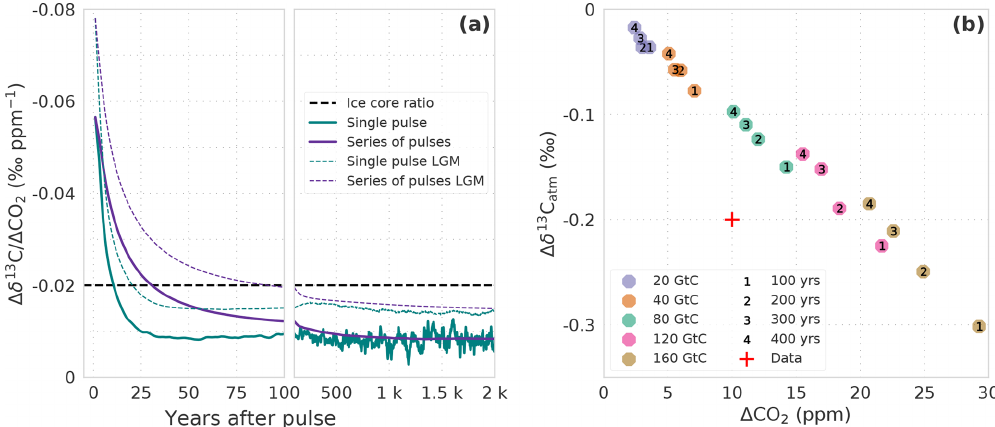
Figure 8. (a) Temporal evolution of the ratio of (cid:49)δ 13 C to (cid:49) CO 2 in the atmosphere. Results are from simulations WEA 100 forced by preindustrial boundary conditions (solid lines) and LGM 100 forced by Last Glacial Maximum boundary conditions (thin dashed lines). Carbon is released as a single pulse at year 0 (green lines) or assumed to be released at a uniform rate from year 0 to the year plotted (purple lines; see main text). The dashed horizontal line indicates a (cid:49)δ 13 C-to- (cid:49) CO 2 ratio of − 0 . 2‰ to 10ppm as seen in ice core records for HS1 and HS4. (b) Response in (cid:49) CO 2 and (cid:49)δ 13 C atm to a uniform release of 20, 40, 80, 120, and 160GtC (colors) of isotopically light carbon ( δ 13 C =− 24‰) to the atmosphere over 100, 200, 300, and 400 years (numbers). Shown is the mean over 30 years starting in the last year of the release. The red cross indicates the approx. (cid:49)δ 13 C-to- (cid:49) CO 2 change as seen in ice core records for HS1 and HS4 (Bauska et al., 2016,